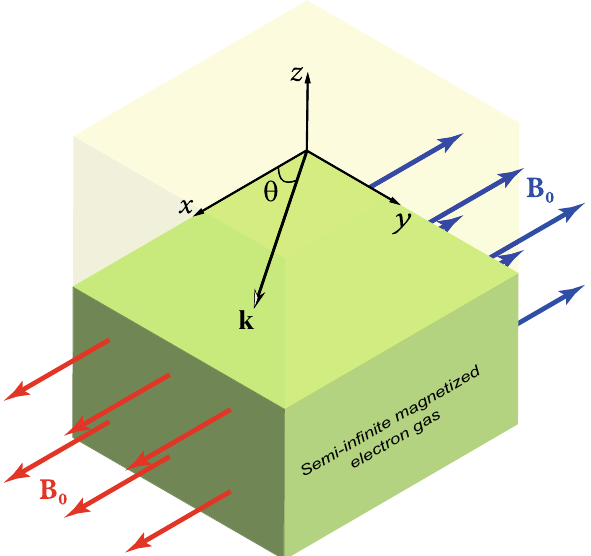
Figure 1. Sketch of a semi-infinite magnetized electron gas with static magnetic field B 0 parallel to the surface. Here we choose the direction of B 0 fixed along the unit vector along the x -axis. Also, k is the wavevector of the propagating surface wave, and θ (or 180 ◦ the angle between k and B 0 . The special cases θ configurations, respectively. Here we study magnetoplasmons for the general case of arbitrary θ , which we call a mixed Faraday–Voigt configuration. Note that in the Voigt configuration the magnetoplasmons travel in the direction. The electron gas is bounded from above by a semi-infinite insulator at z